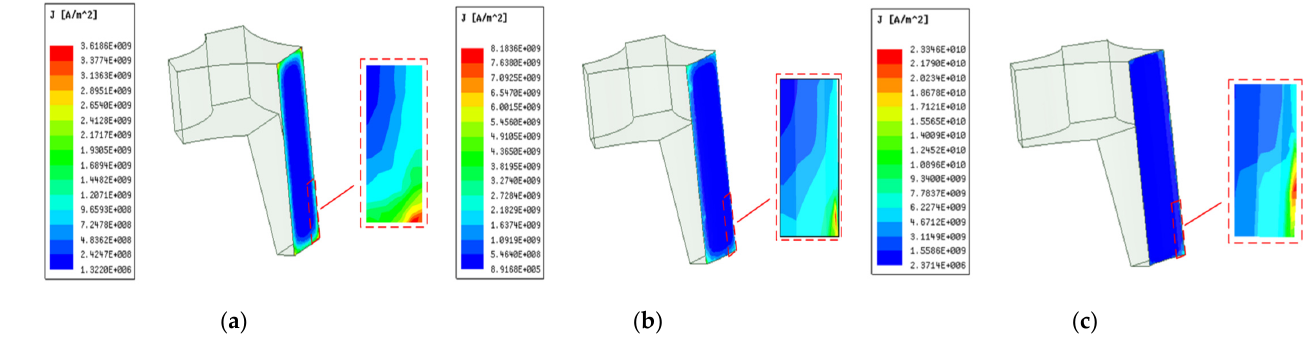
Figure 4 . Current density distribution on the contact surface of three armatures: ( a ) planar type armature; ( b ) convex elliptical armature; ( c ) concave elliptical armature.